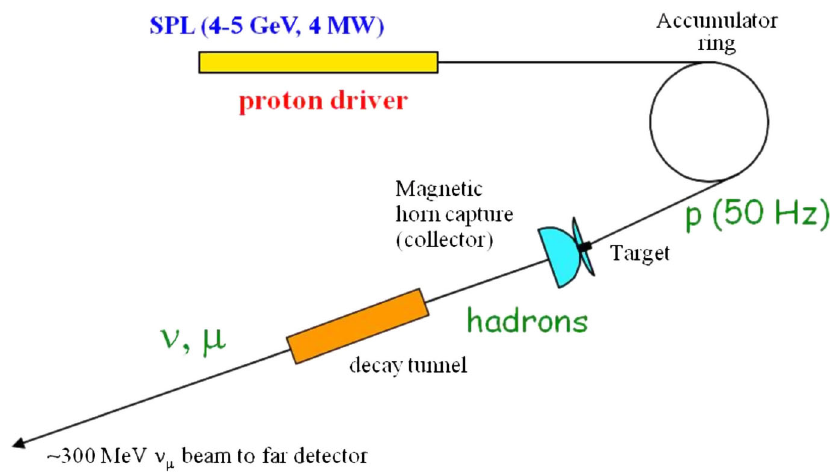
FIG. 1. Layout of the CERN to Fre´jus Super